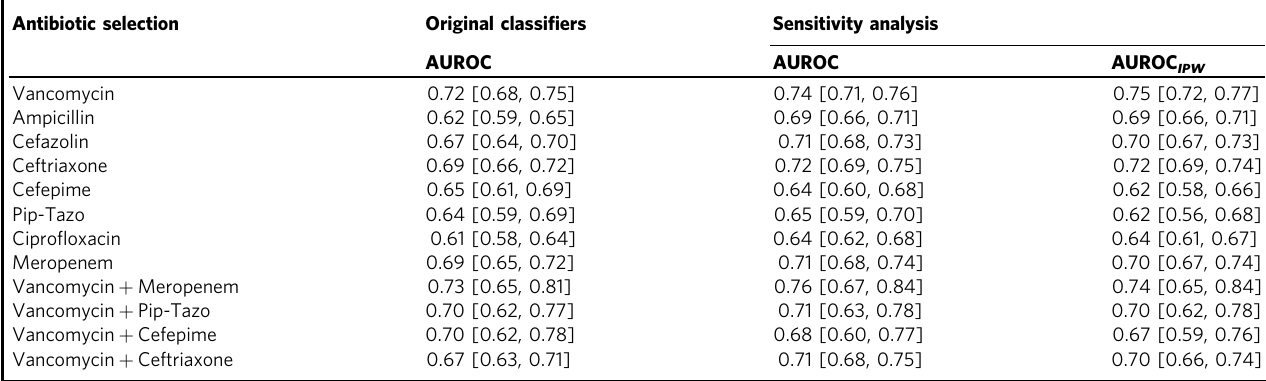
Table 5 Personalized antibiogram sensitivity analysis with and without inverse probability weights: Pip-Tazo = piperacillin/